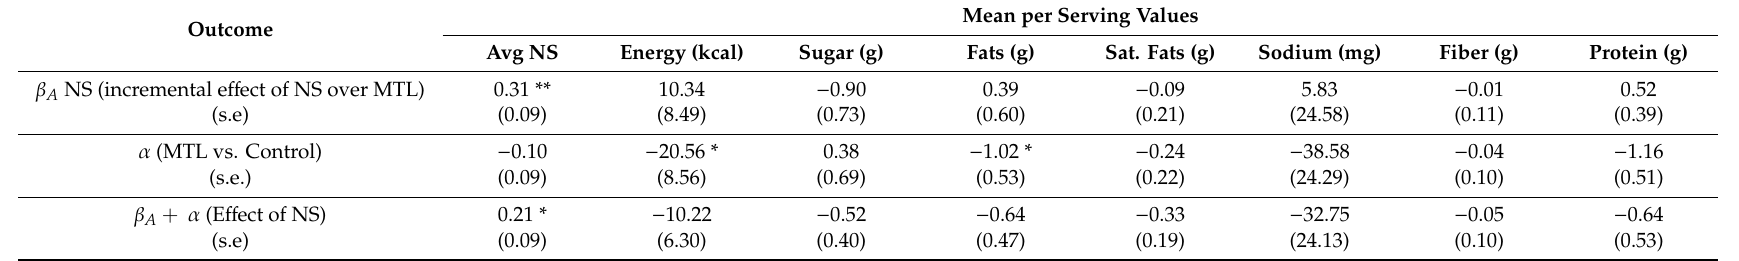
Table A3. Regression for foods only dietary quality and per serving values as outcomes ( N = 287, n = 146).